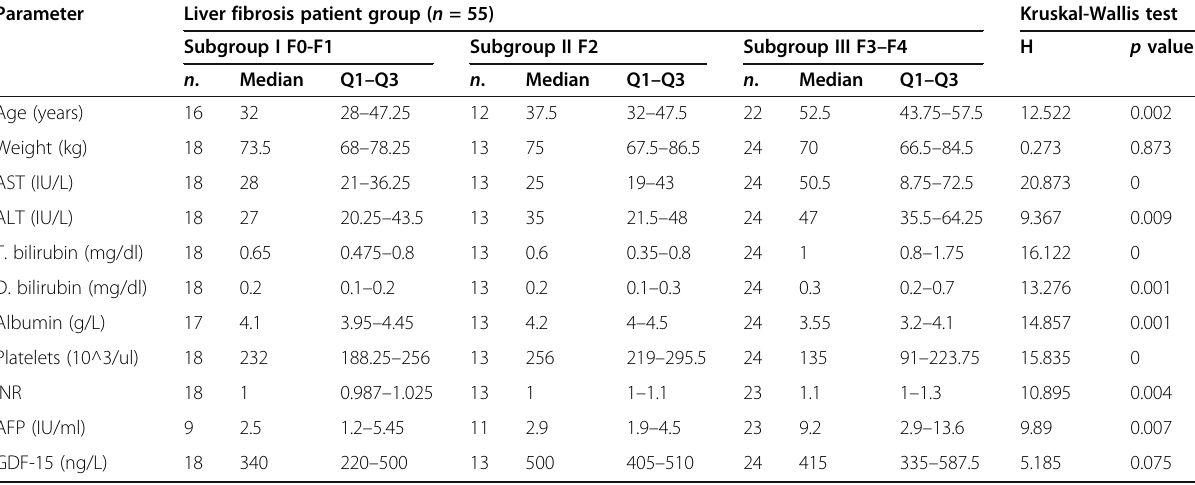
Table 2 Descriptive and comparative statistics of the different studied parameters in the different patient subgroups Parameter